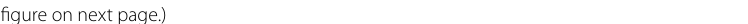
figure on next Fig. 2 Combined urine miRNA and SERS profiling correlates with the molecular classification of bladder cancer (BC). A Immunohistochemical staining aspect of luminal type BC. B Immunohistochemical staining aspect of basal type BC. C The two differentially expressed miRNAs by NGS analysis between luminal and basal BC. D The average SERS spectra of urine for the luminal and basal BC. E The score values of principal component (PC) 8 in luminal versus basal BC. F Loading plot of PC8. G – I Head-to-head comparison of the receiver operating characteristic (ROC) curves for the classification accuracy yielded by miRNA alone, SERS alone or the combination of the two using three supervised classification algorithms (naïve Bayes (G), logistic regression (H) and random forest (I)) for luminal and basal BC. Mean SD. ***p < ±